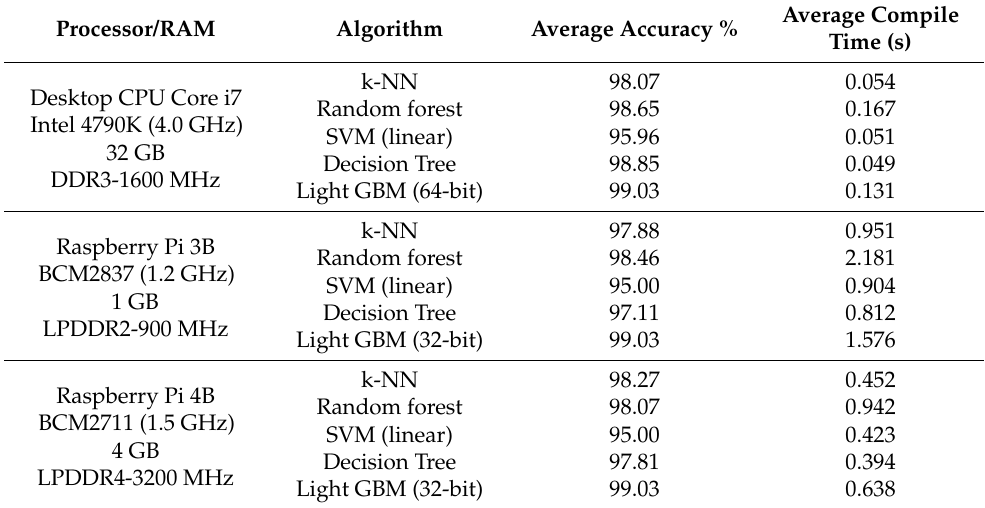
Table 4. Average accuracy and compile time on Spyder IDE (Python